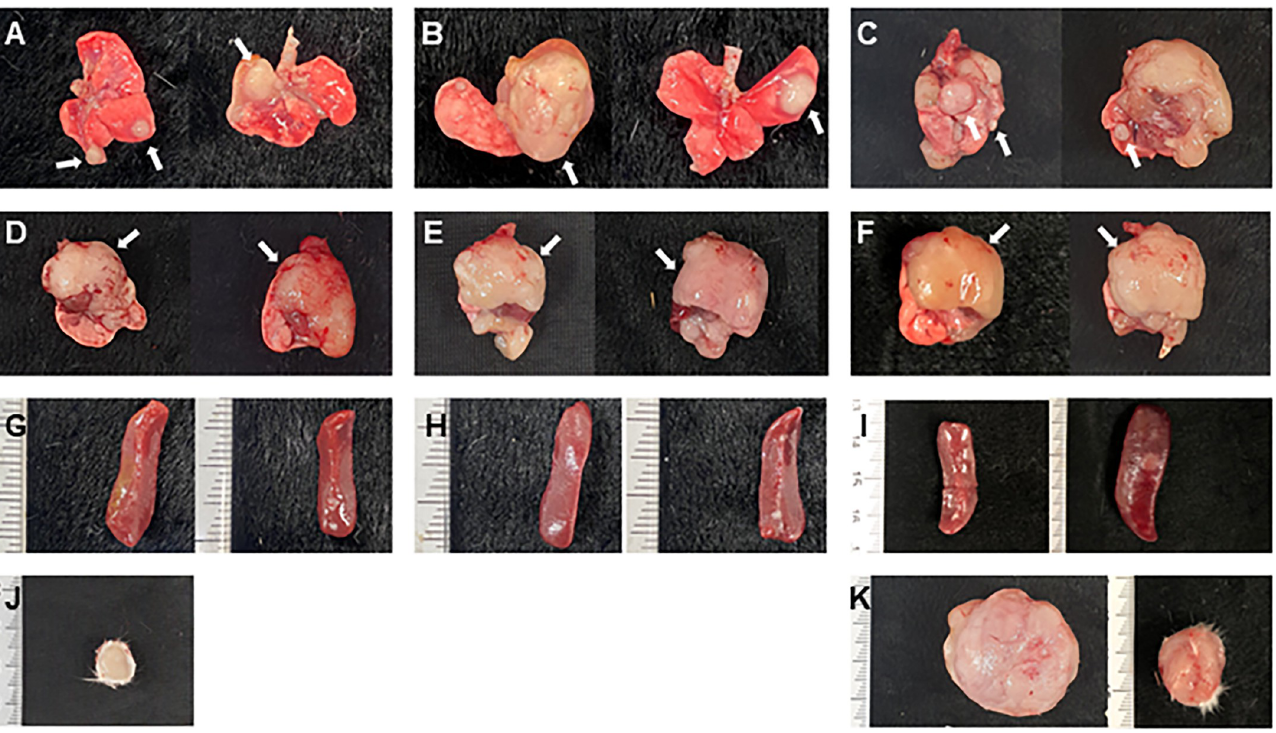
Fig 3. Representative images of gross lesions after MNU administration in different dosages. Macroscopic appearance of large mass (white arrows) in the lungs (A, B, C), and thymus (D, E, F) shown in FVB-p53 +/- mice of the 25mg/kg (A, D), 50mg/kg (B, E), and 75mg/kg (C, F) group. Splenomegaly (G, H, I) and a large subcutaneous mass (J, K) shown in the FVB-p53 +/- mice of the 25mg/kg (G, J), 50mg/kg (H), and 75mg/kg (I, K) group.